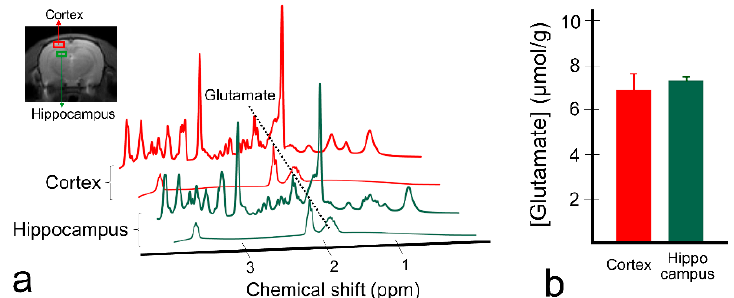
Figure 5. Fitted spectra results of proton magnetic resonance spectroscopy ( 1 H MRS) in two brain regions (cortex and hippocampus) from a representative rat ( a ) and quantified glutamate concentrations from the rats ( n = 5) scanned with 1 H MRS ( b ). A black-dotted line was placed on the glutamate peak at 2.35 ppm. The bars represent mean values of glutamate concentration, and error bars represent standard deviations.